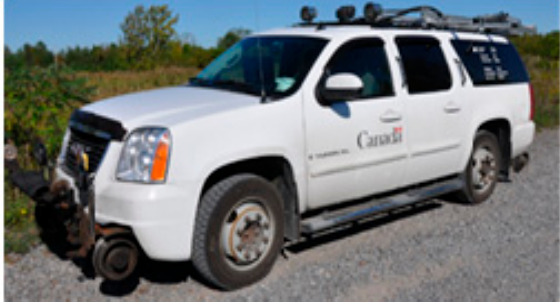
Figure 1. Transport Canada rail inspection vehicle.